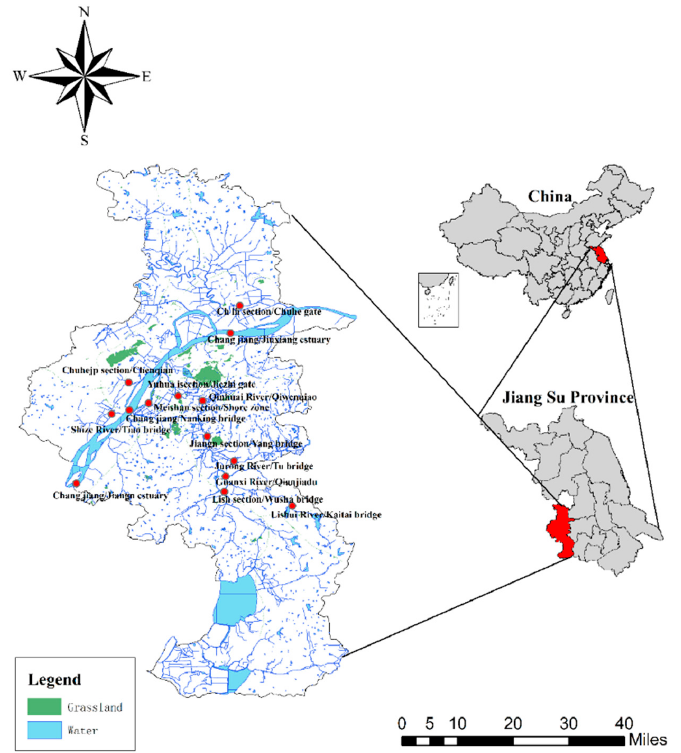
Figure 3. Geology and geographic location of the research area. Table 2. The measured data of surface waters in Nanking during the 2017